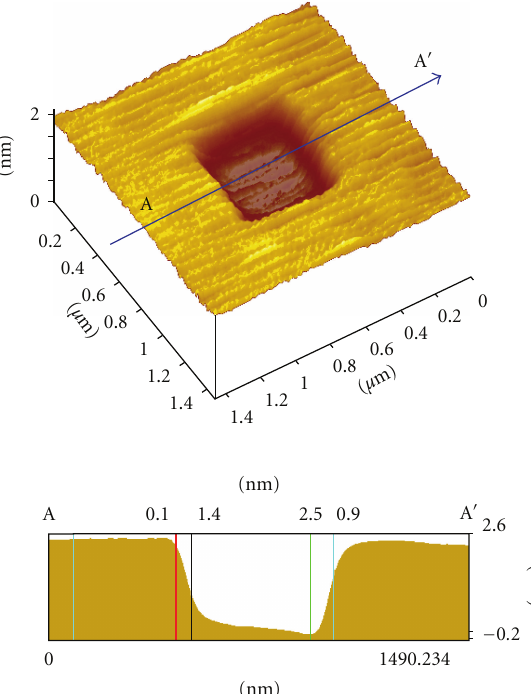
Figure 19: Profile and cross-sectional images of 4-nm-period (C/BN)n topography at 3500 nN load.